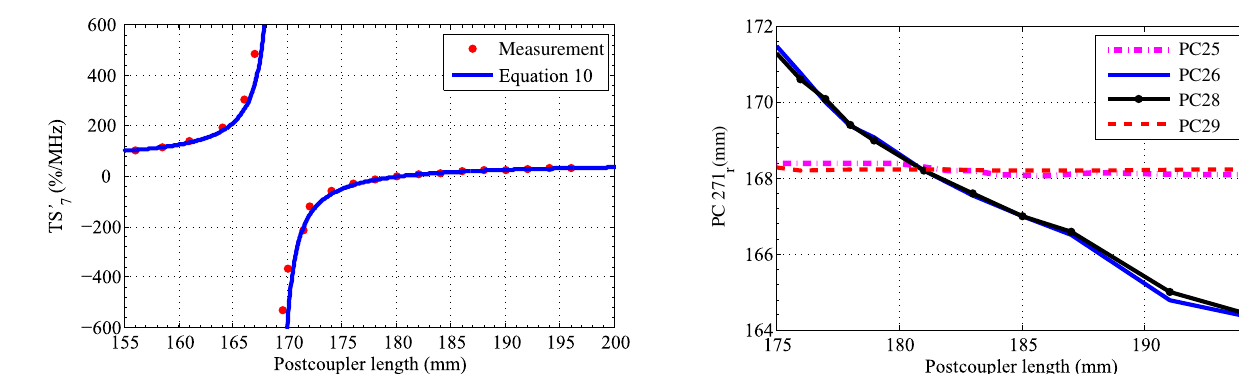
FIG. 7. The dependency of resonance length l r 27 on the neighboring post-couplers. The nearest-neighbor post-couplers influence the resonance strongly but from the second nearest neighbors, post-couplers do not affect l r 27 . This important result allows for adjustment of every second post-coupler concurrently.